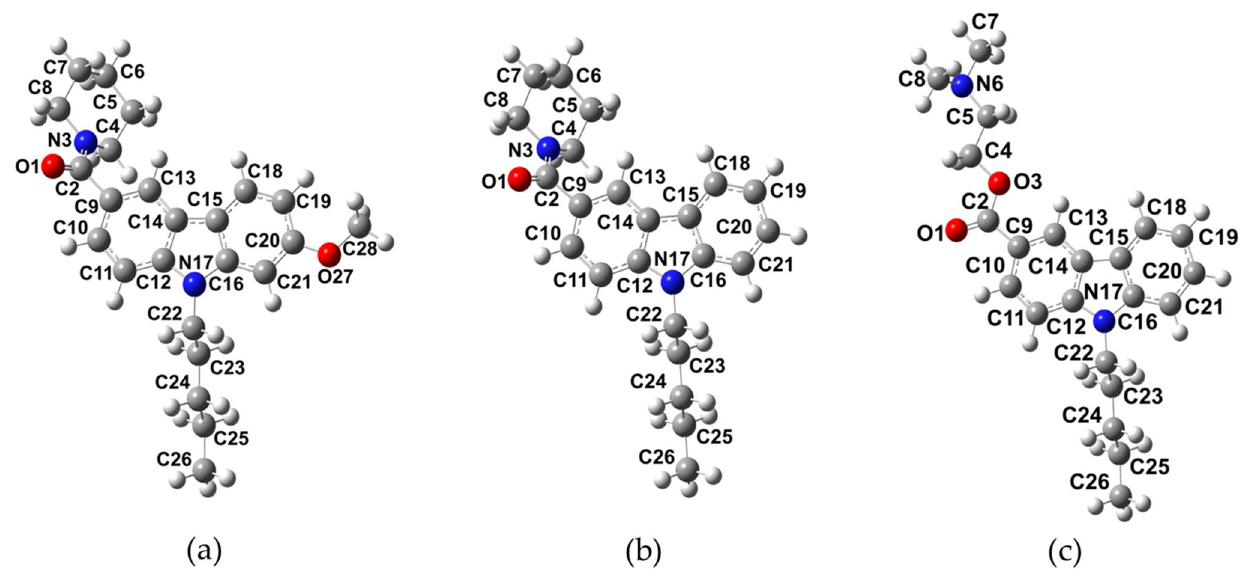
Figure 1. Optimized structures of NMP compounds: ( a ) NMP-4, ( b ) NMP-7, and ( c ) NMP-181 obtained at the BP86/cc-pVTZ level of theory using chloroform as solvent. Table 1. Selected bond lengths (Å), valence angles, and dihedral angles (degrees) for the NMP compounds at the BP86/cc-pVTZ level of theory in